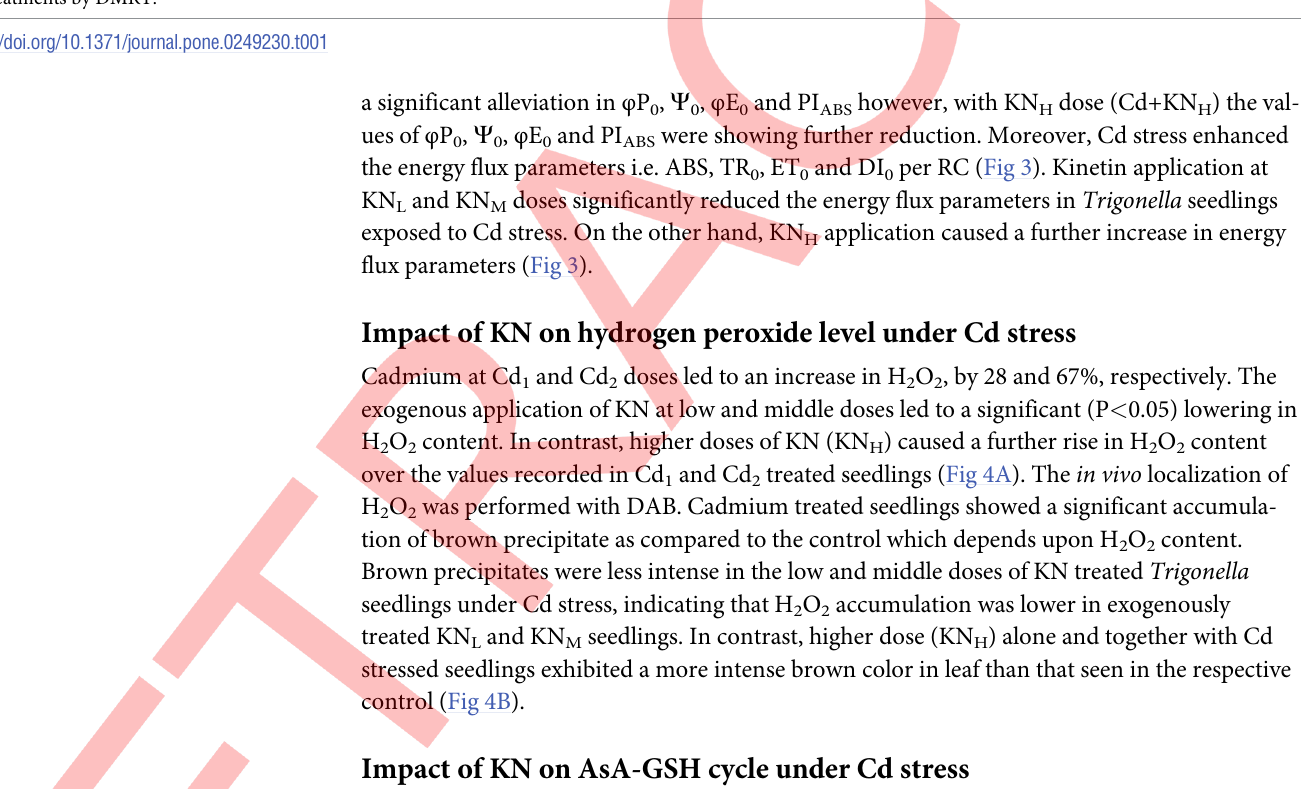
Data represent the mean value ± standard error from three replicates (n = 3). Values followed by the different superscripts within same column differ at P < 0.05 among the treatments by